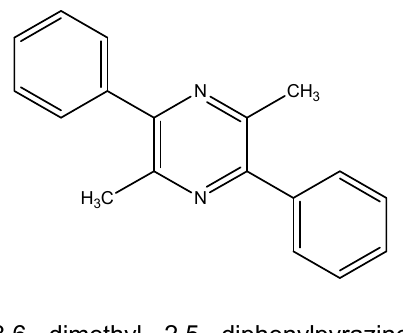
Figure 9. A dimer that is formed as a result of the decomposition of cathinone.